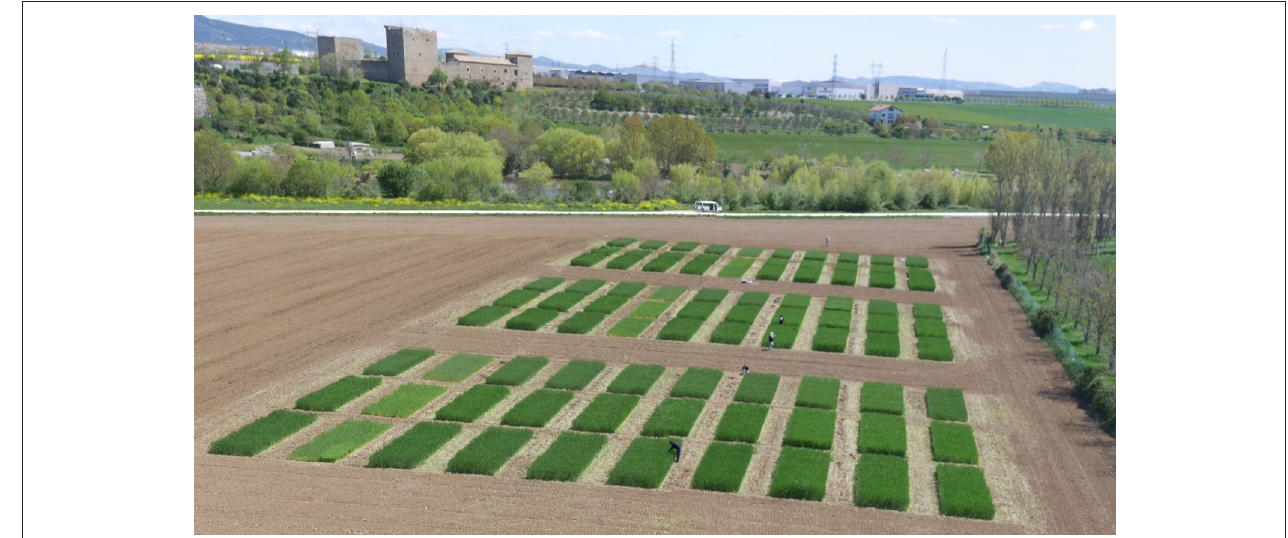
FIGURE 1 | Field experiment at Arazuri Station in Navarra (Spain) during the crop season of 2015/2016.